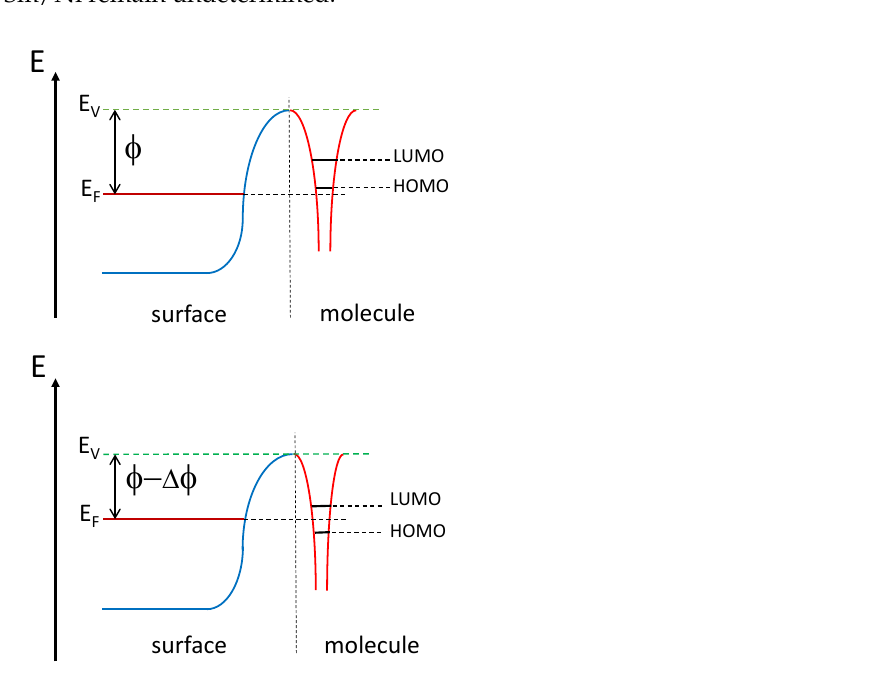
Figure 8. Schematic representation of relative changes in electron energy levels that result from a reduction in sample work function. The Fermi level and vacuum level are denoted E F and E V , respectively. φ is the work